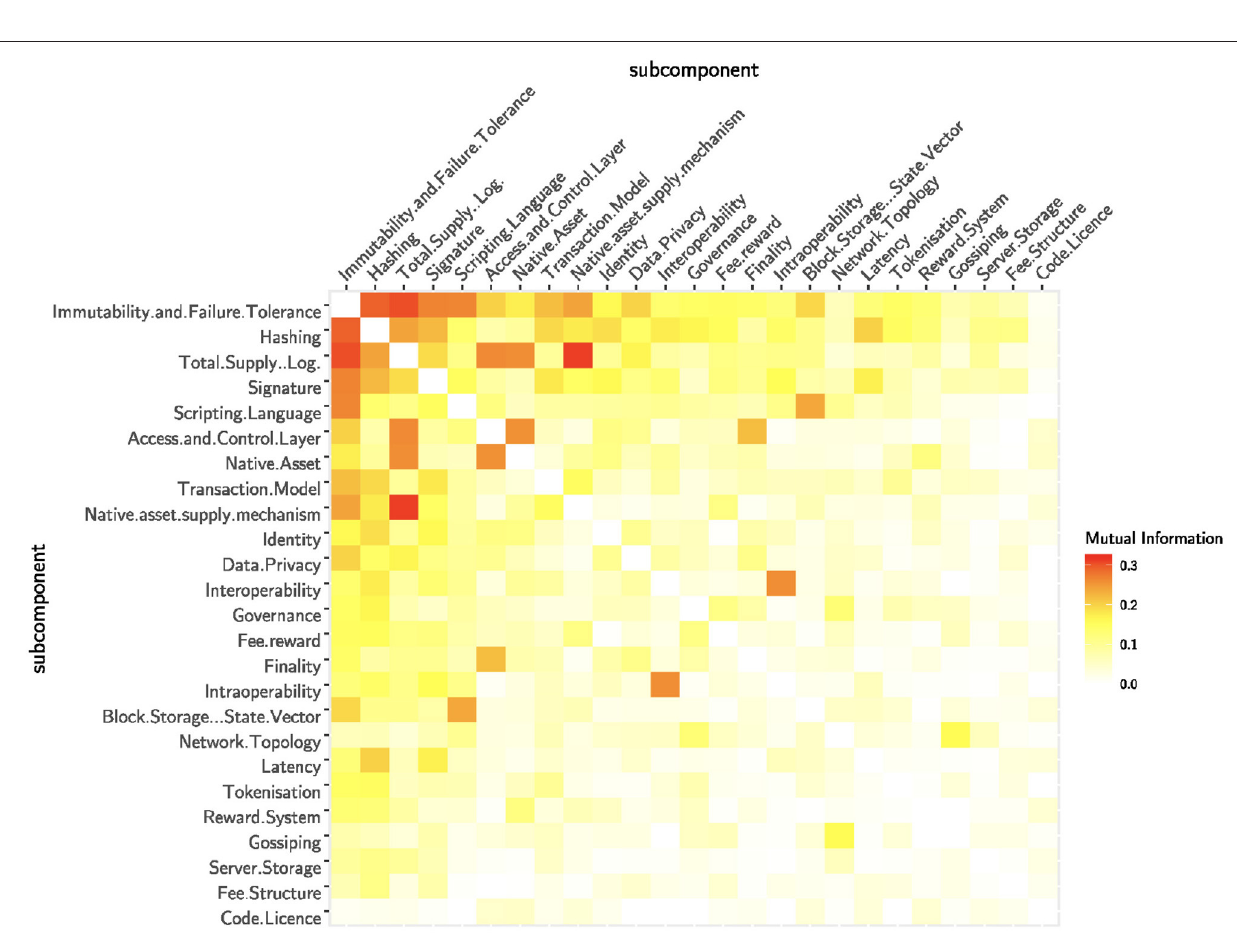
Frontiers in Blockchain |